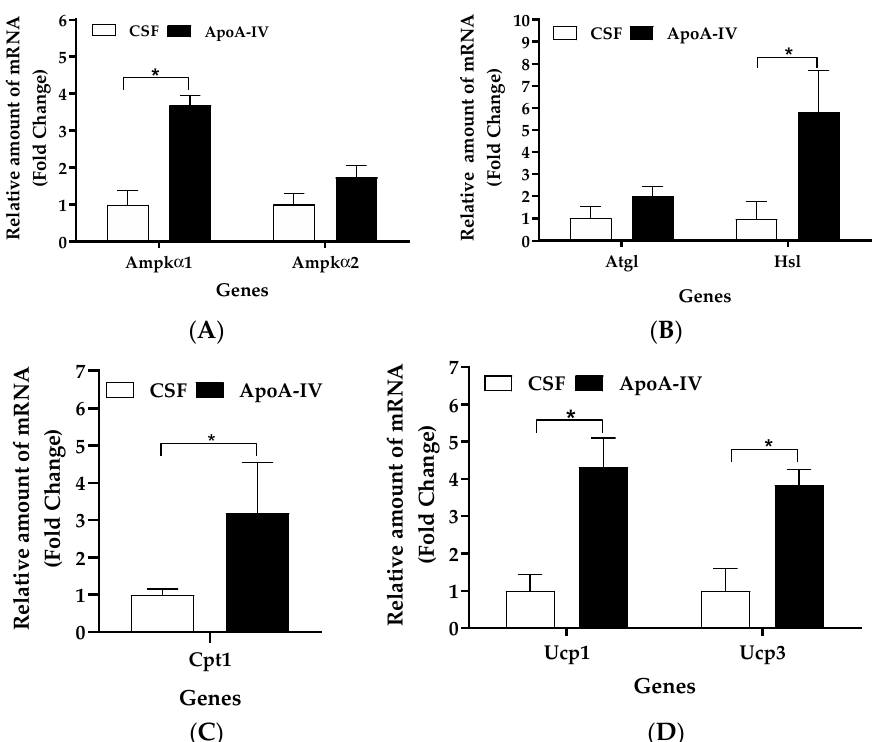
Figure 2. Lipolytic and thermogenic gene expression in adipose tissues. Levels of Ampk α 1 and Ampk α 2 ( A ), Atgl and Hsl ( B ), Cpt1 ( C ), and Ucp1 and Ucp3 ( D ) gene expression were measured by qRT-PCR. Mice received central administration of either CSF (1 µL) or ApoA-IV (12 µg in 1 µL) into the third ventricle, and BAT was collected at 40 min post-injection. Data are expressed as the means ± SEM for 6–7 mice per group. * Represents a significant difference relative to CSF-treated controls ( p <